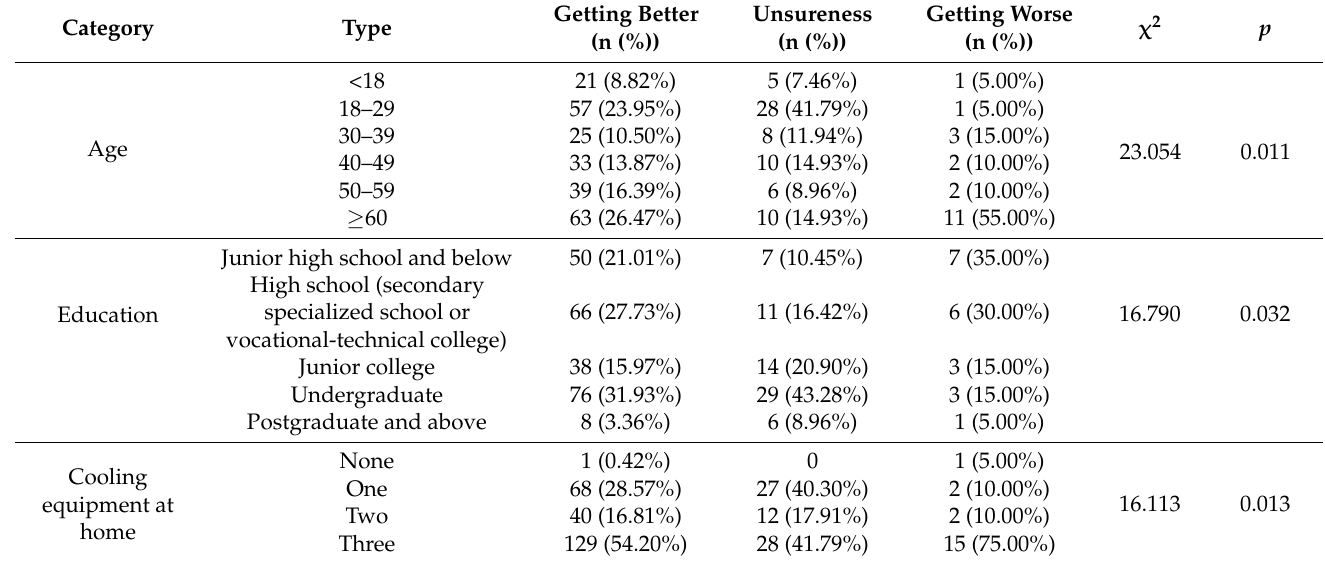
Table 4. Differences in judgments of the trend of cooling effect for different groups of